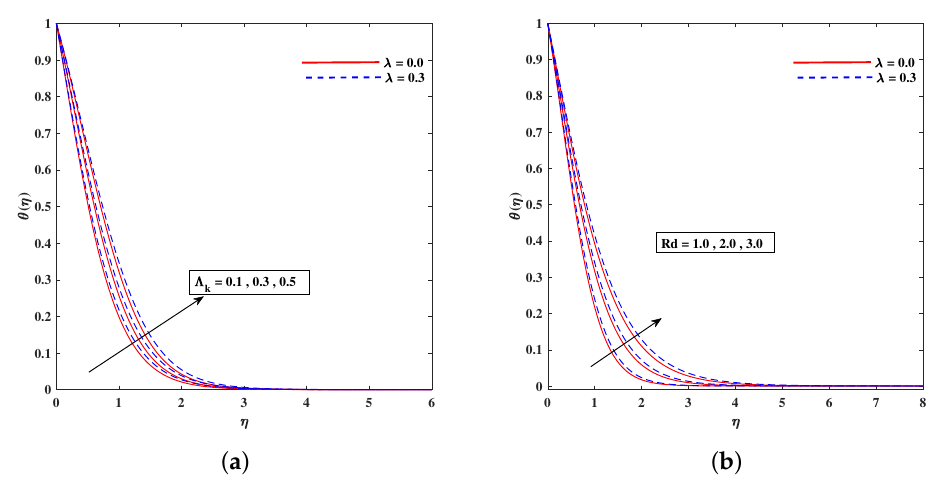
Figure 11. Fluctuation of ( a ) Λ k and ( b ) Rd on temperature profile θ ( η ) .